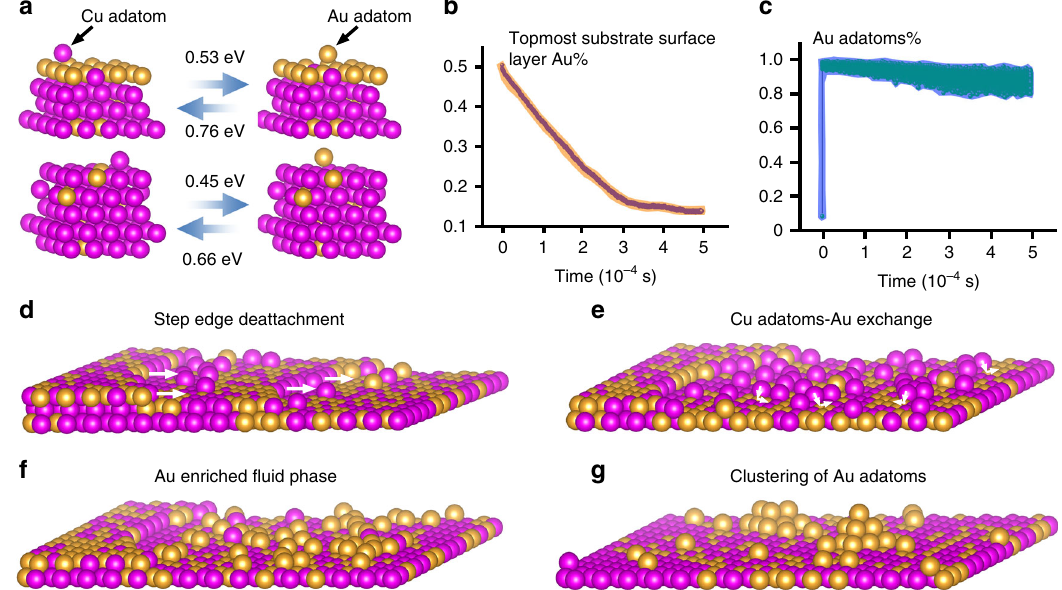
Fig. 2 Adatom – substrate exchange induced phase separation in a Cu – Au fl uid phase. a NEB calculations of the adatom-substrate exchange barriers. Upper panel: exchange between a Cu adatom and an Au-rich substrate surface; lower panel: exchange between a Cu adatom and a Cu-rich substrate surface. b , c KMC simulations of the Au composition evolution in the topmost substrate surface layer and the fl uid phase, respectively. d – g Schematic illustrating the phase separation process from the formation of a Cu – Au fl uid phase of Cu and Au adatoms by step-edge detachments to the adatom – substrate exchange induced enrichment of Au atoms in the fl uid phase and then to the clustering of Au adatoms (Supplementary Movie